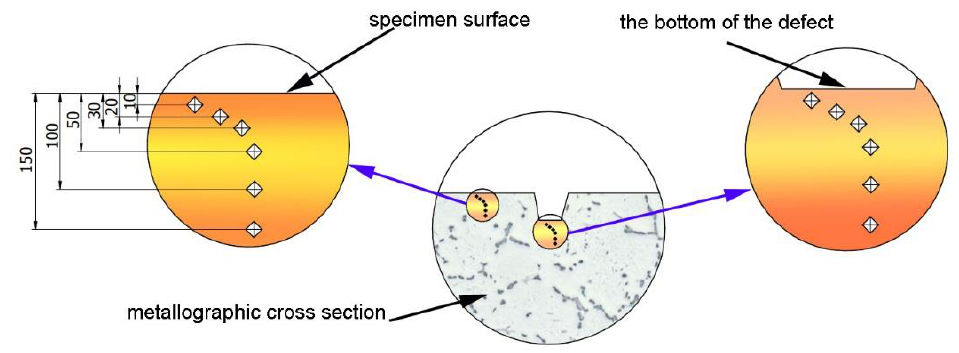
Figure 6. Methodology of microhardness measurement.